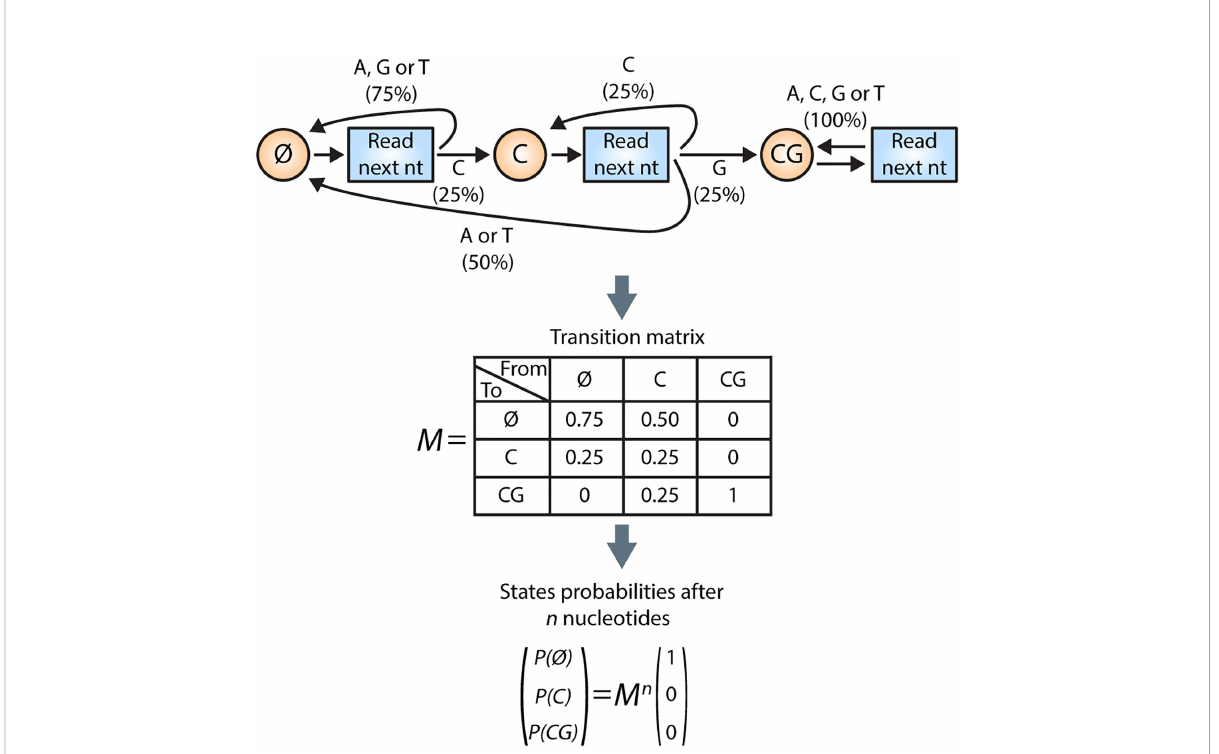
FIGURE 1 Illustration of a Markov chain to compute the probability to fi nd the CG pattern in a sequence of length n . The Markov chain for this basic example contains three states: Ø, C, and CG. The chain starts in the Ø state and will read the nucleotides (nts) one by one. From state Ø, there is a 75% chance that the next nucleotide will not match the fi rst nucleotide of the CG pattern. Therefore, from Ø state, the probability of reaching state C is only 25%, whereas the probability of remaining in state Ø is 75%. From state C, reading the next nucleotide gives three options (1): the next nucleotide is a G, leading to the CG state (with a probability of 25%) (2); the next nucleotide is again a C, i.e., we remain in the C state (with a probability of 25%); or (3) the next nucleotide is neither a C nor a G, resulting in a return to the Ø state (with a probability of 50%). When the CG state is reached, the pattern is found and, even if next nucleotides can be read, the chain is blocked in the CG state, a so- called absorbing state. This chain can be mathematically summarized by a transition matrix M. The probability of the three states after reading n nucleotides is given by the transition matrix at the power n multiplied by the initial conditions. Code to reproduce this basic example and the computation for the 19 nucleotides pattern is avalaible on OSF